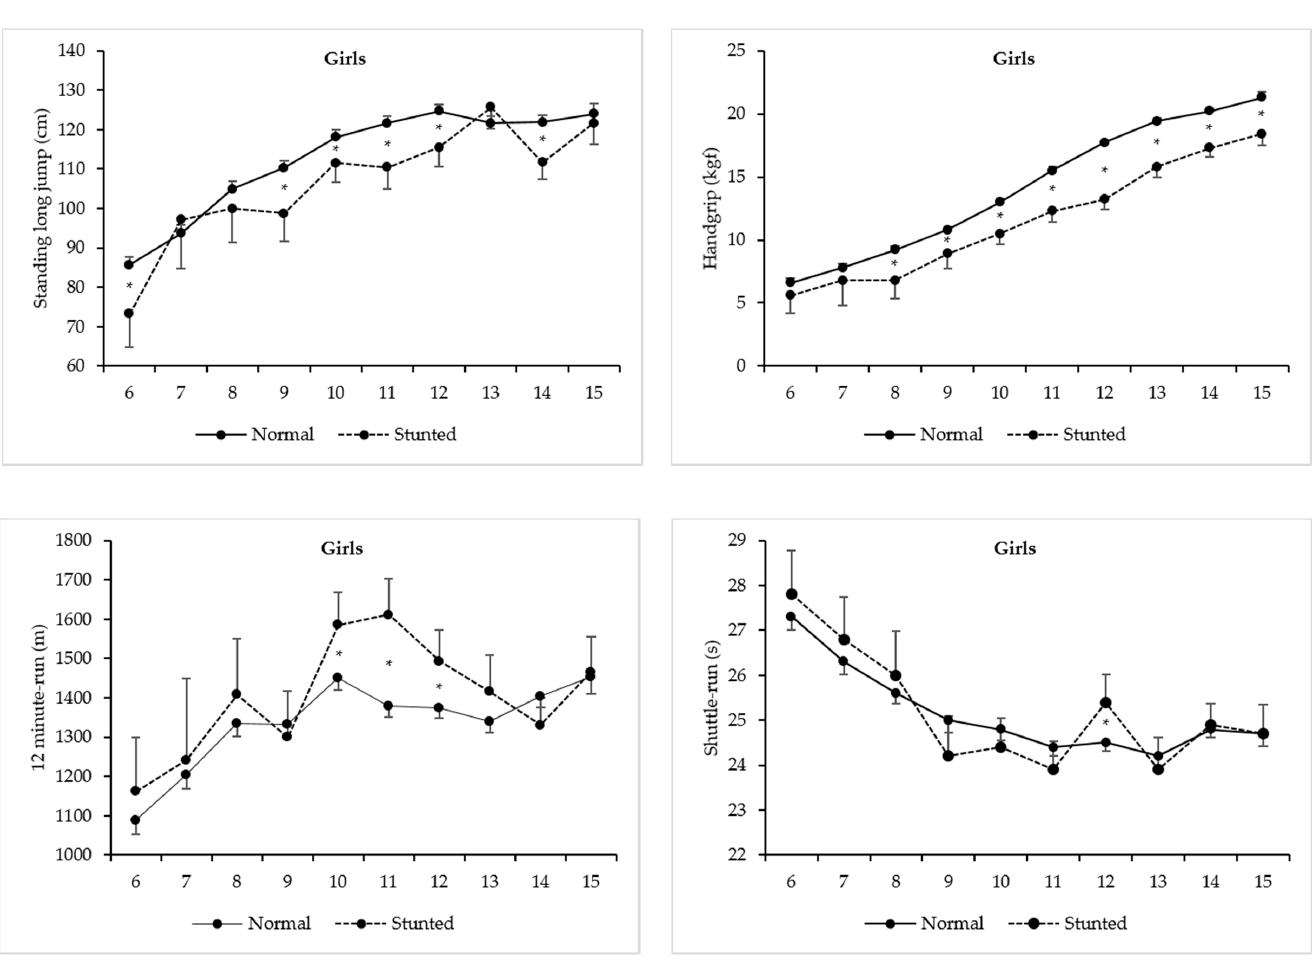
Figure 2. Mean levels for each physical fitness test between stunted and normal-growth Peruvian girls (* marks statistical significant di ff erences; 95% Confidence